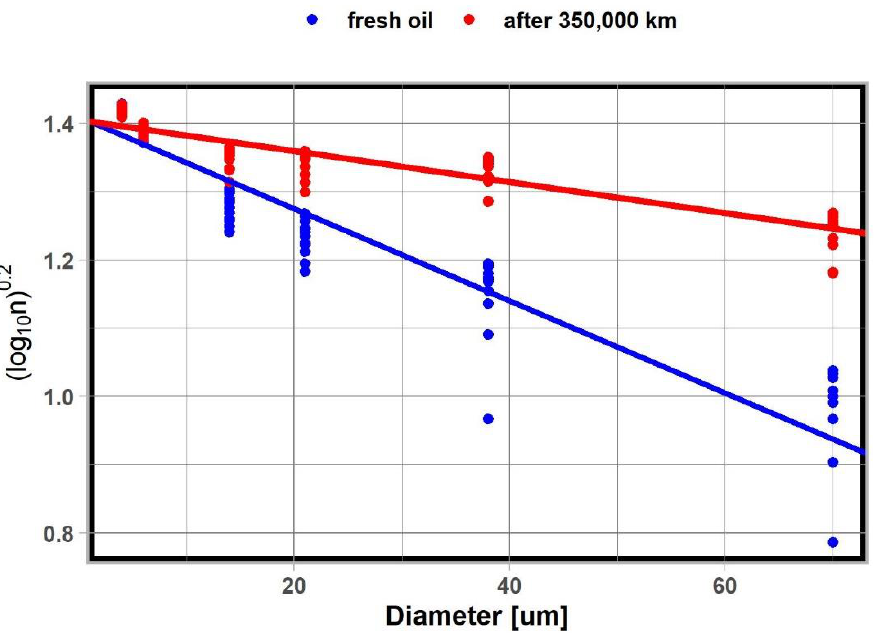
Figure 8. Regression model of particle content as a function of particle diameter of fresh and used (350,000 km) gear oil SAE 75W-140. Table 3. Basic parameters of the linear regression model for oil 75W-140.